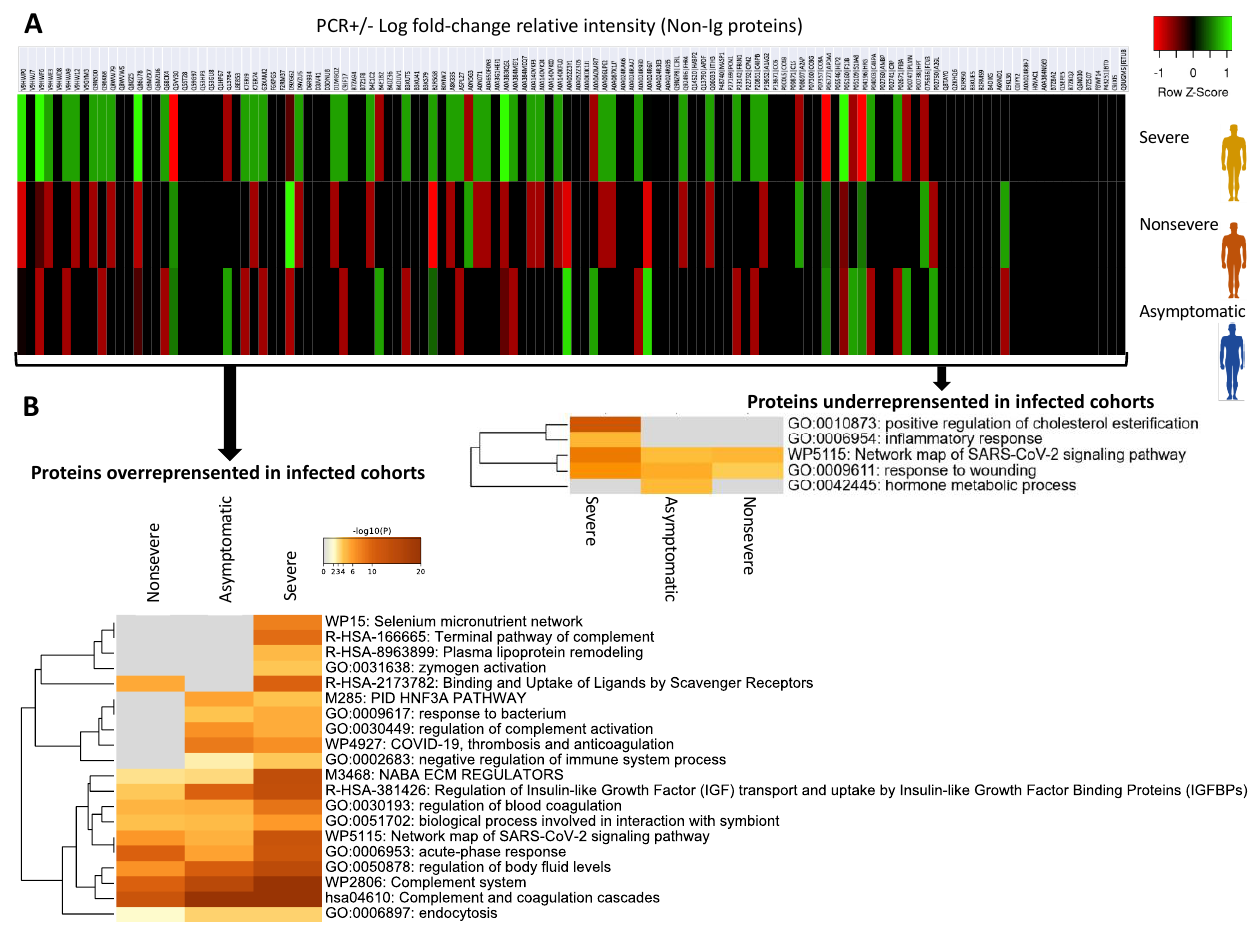
Figure 6. Multiple differential representation and enrichment ontology clusters for non-Ig proteins.